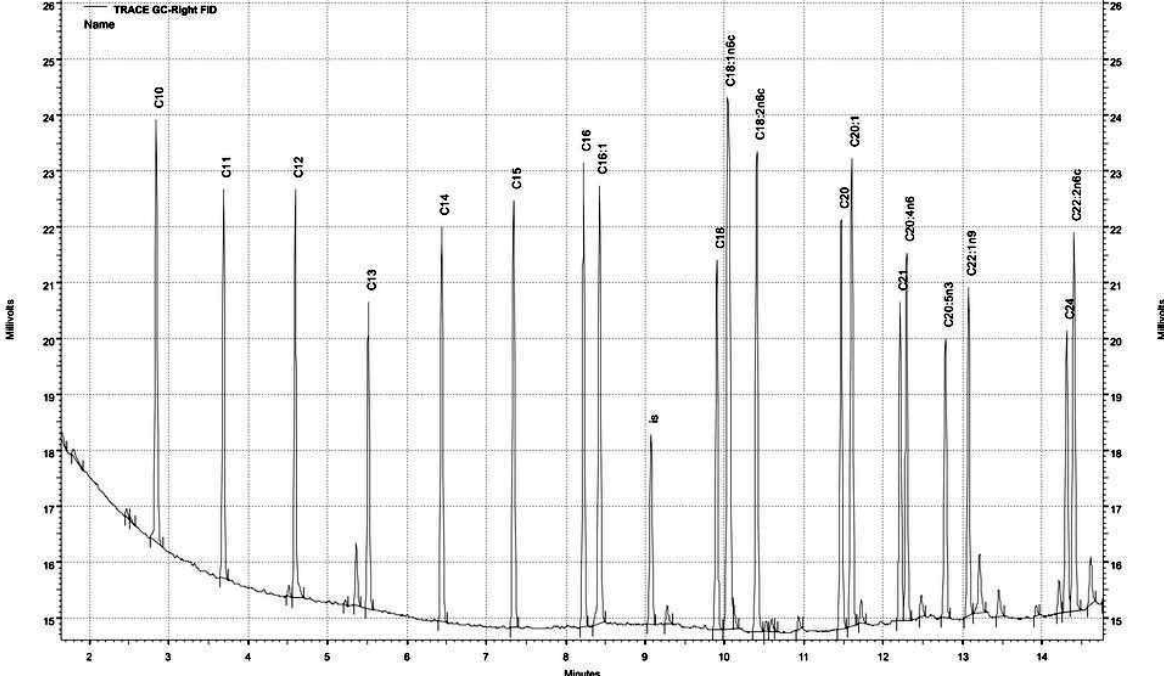
Figure 1. The internal standard fatty acids were processed to Methyl esters. GC-MS analysis was performed using Shimadzu GC-MS-QP-2010. Separation was performed on a teknoroma brand column (TR-CN100). Helium was used as the carrier gas with a flow rate of 1 ml/min. Free fatty acid methyl esters were separated at constant flow with the following temperature program: 100 °C (10 min) to 250 °C at 4